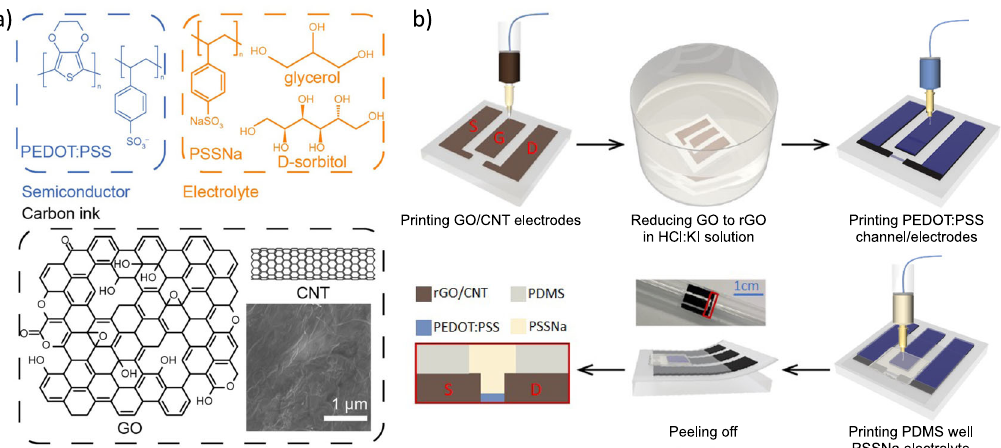
Fig. 1 Materials and device fabrication steps. a Chemical structure of the semiconductor (PEDOT:PSS), electrolyte (PSSNa, glycerol, and D- sorbitol), and carbon ink electrodes (GO and CNT). The inset shows an SEM image of the rGO/CNT blend fi lm. b Schematic of the OECT fabrication process and fi nal device